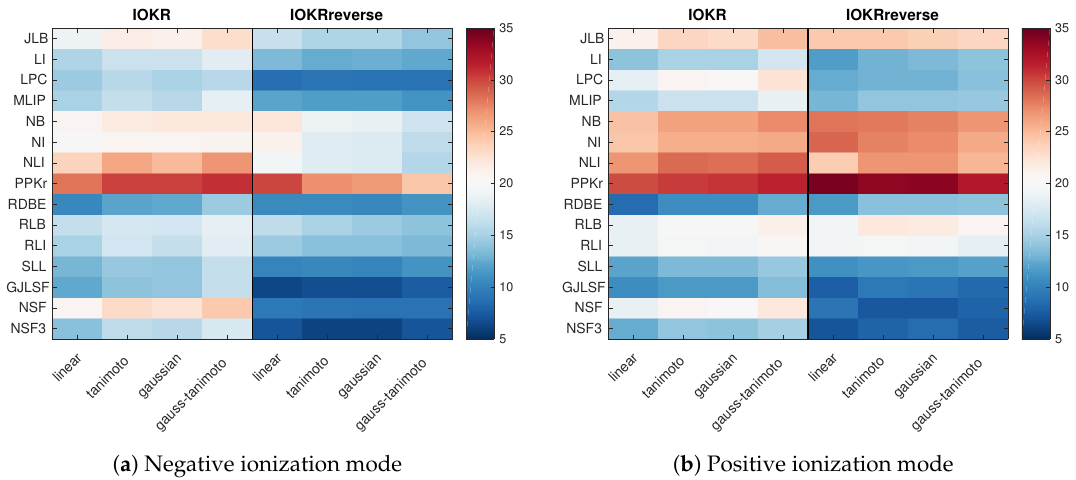
Figure 2. Heatmap of the top-1 accuracy obtained with IOKR and IOKRreverse for different input and output kernels in the negative ionization mode ( a ) and the positive ionization mode ( b ). The rows correspond to the different input kernels while the columns indicate the output kernels.